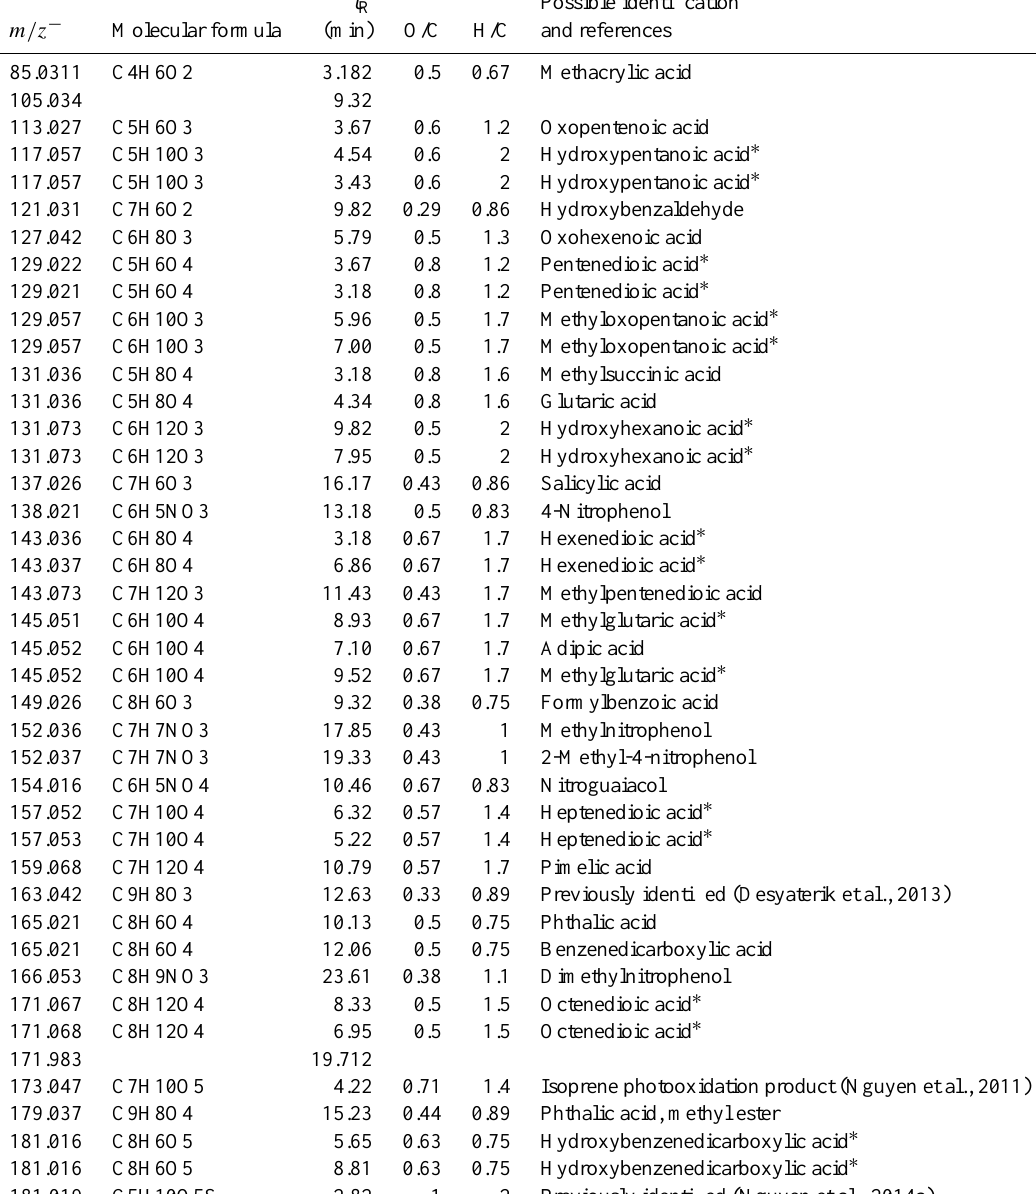
Table 2. Chemical formulae and possible structures of organic components identified via HPLC-(-)-ESI-HR-ToF-MS within BYI fog water samples. Formulae with multiple isomers (different retention times) are marked with an asterisk ( ∗ ). Multiple plausible formulae were identified for species prefixed with “e.g.”. Only species with mass spectral abundances ≥ 500 abundance units were